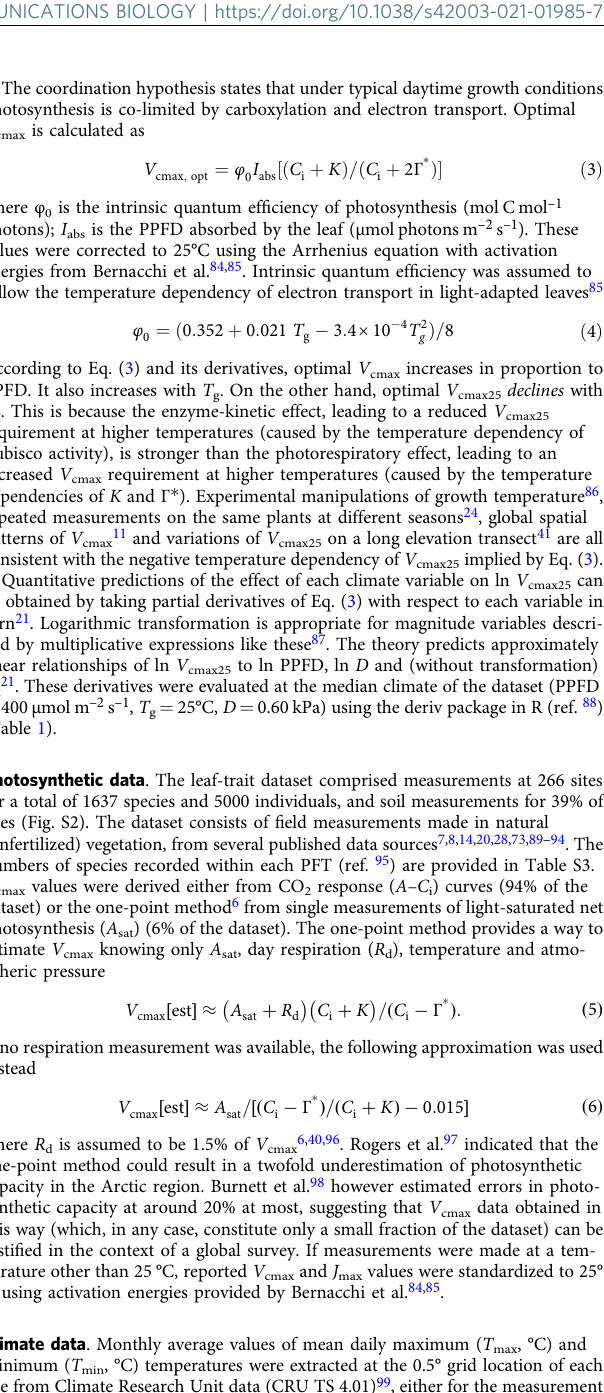
ffiffiffiffiffiffiffiffiffiffiffiffiffiffiffiffiffiffiffiffiffiffiffiffiffiffi β K þ Γ *